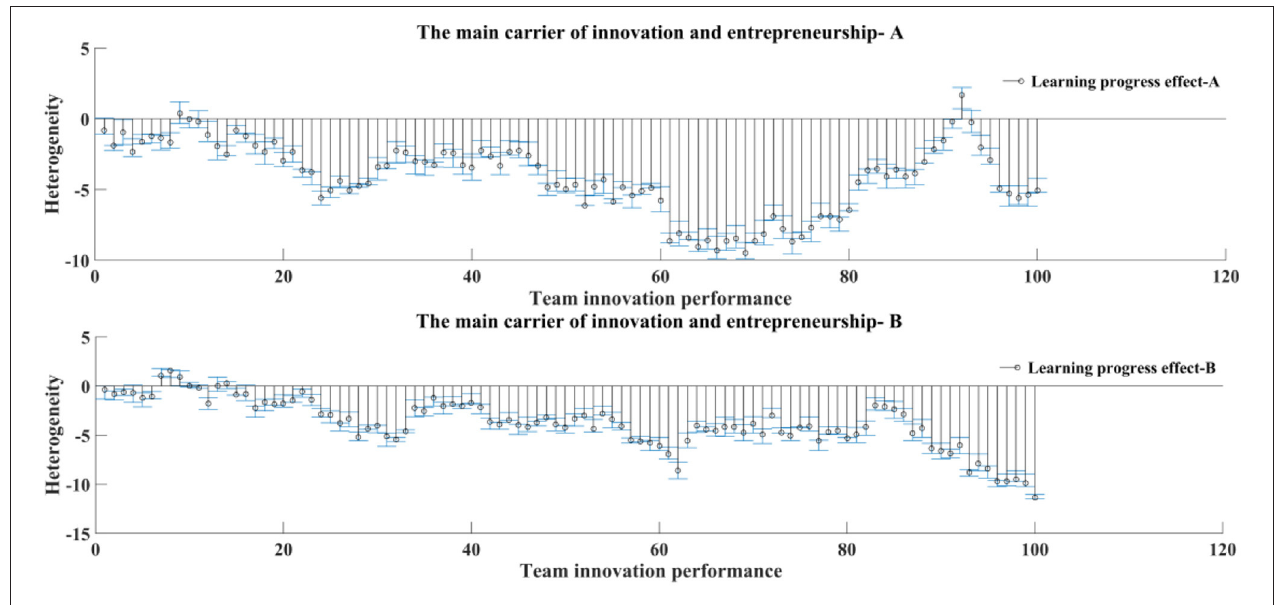
FIGURE 9 | The main carrier of innovation and entrepreneurship.